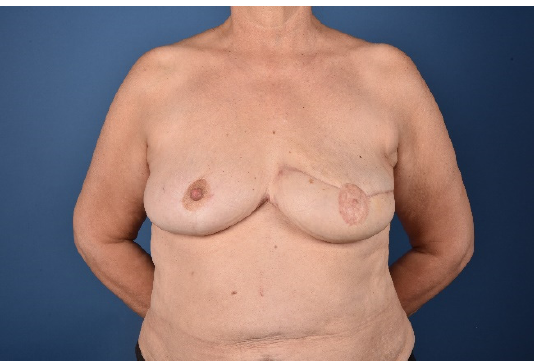
Figure 7. One-year postoperative result.